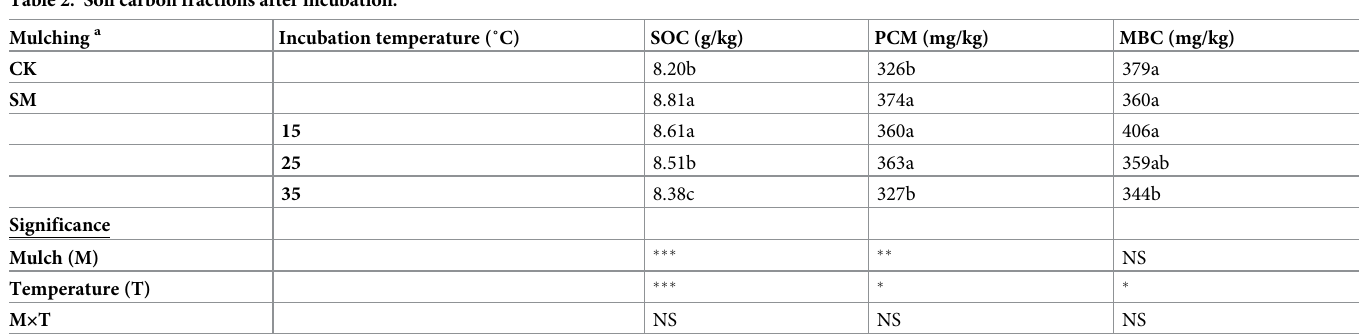
Table 2. Soil carbon fractions after